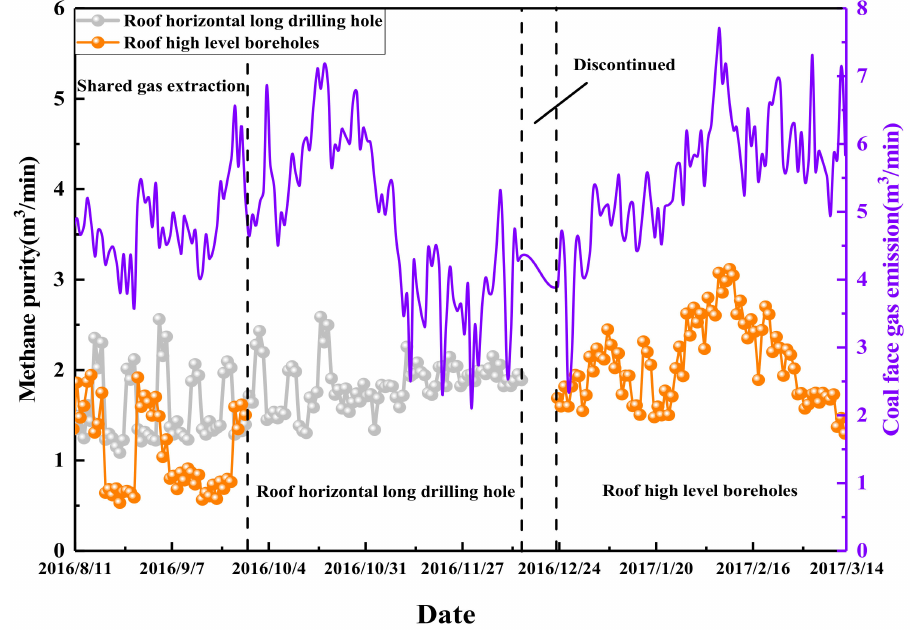
Figure 14. The variation of working face methane emission and drainage scalar over time.